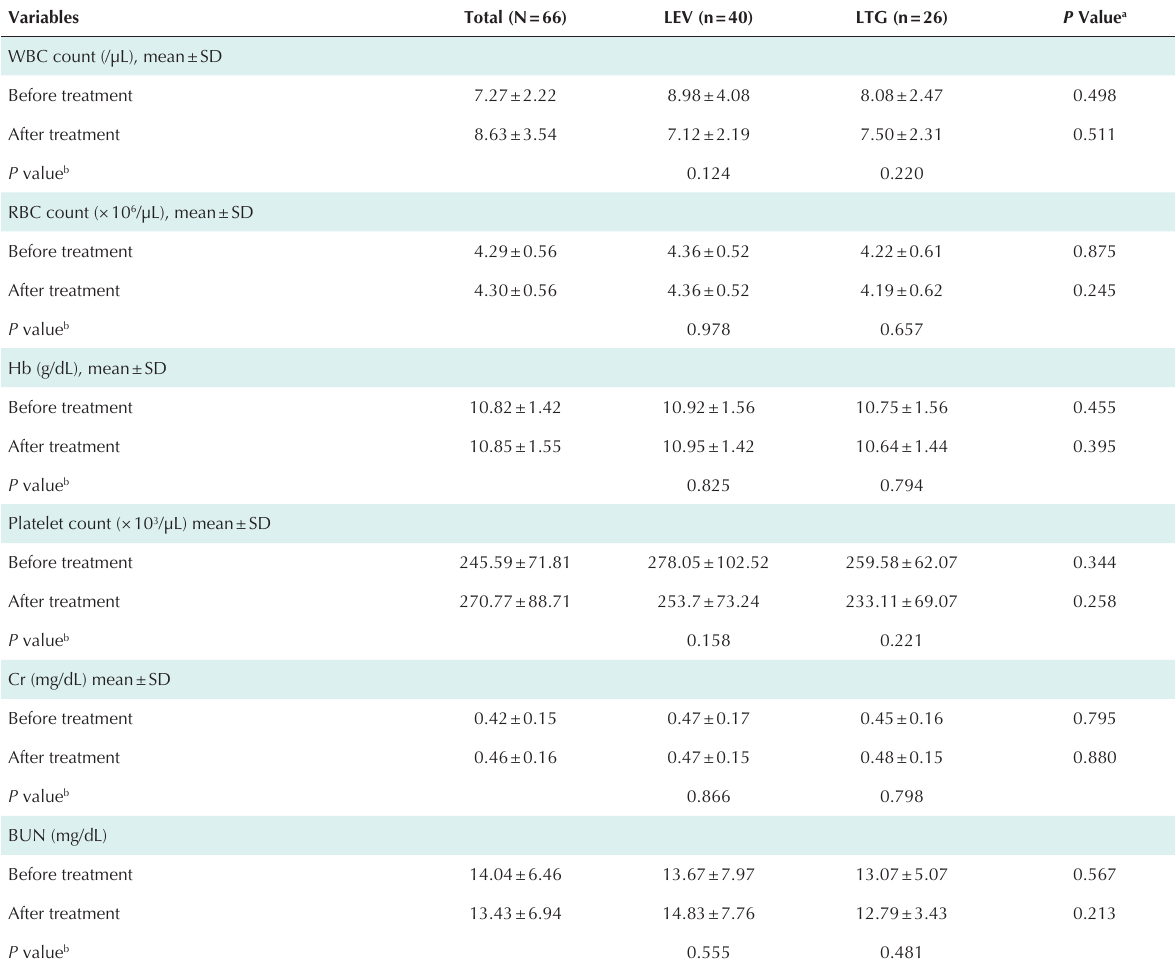
Table 2. Comparison of Hematological and Renal Parameters Between Groups Before and After Treatment Variables Total (N = 66) WBC count (/µL), mean ± SD